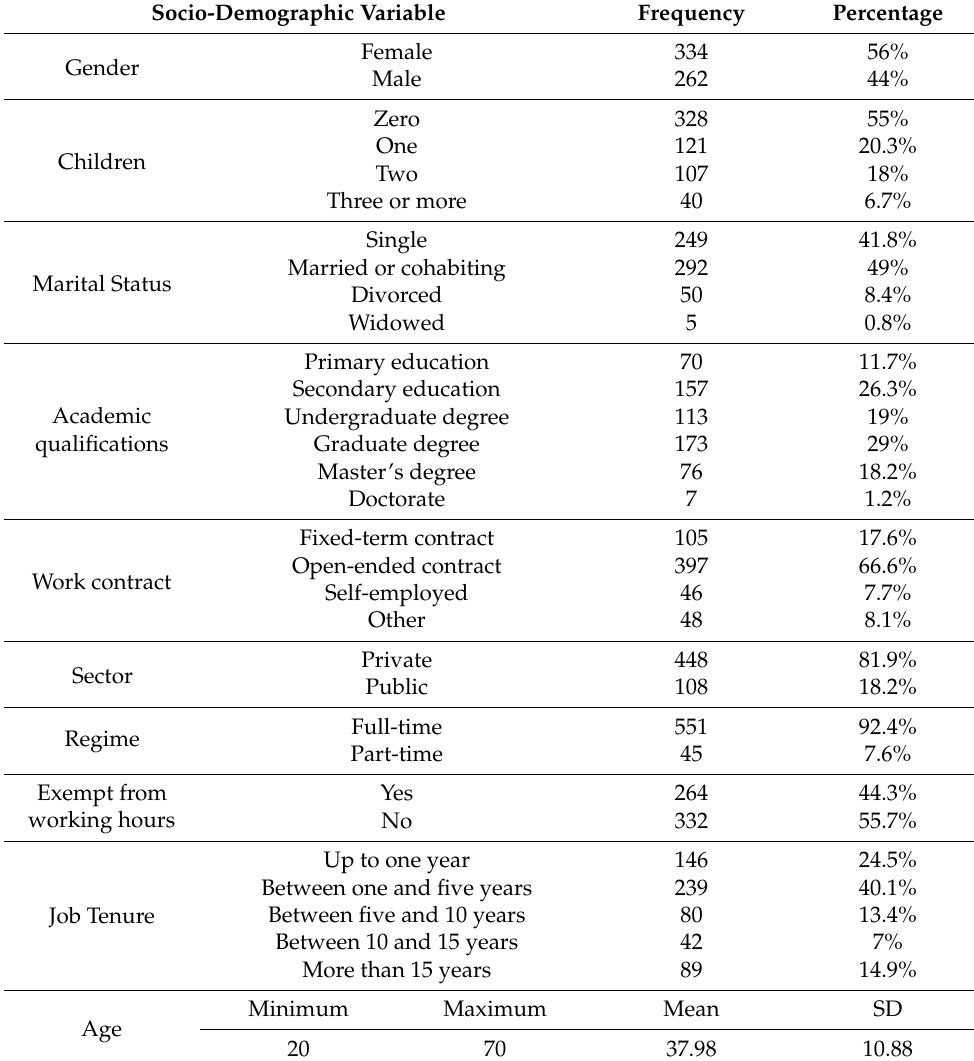
Table 1. Sociodemographic Variables Descriptive